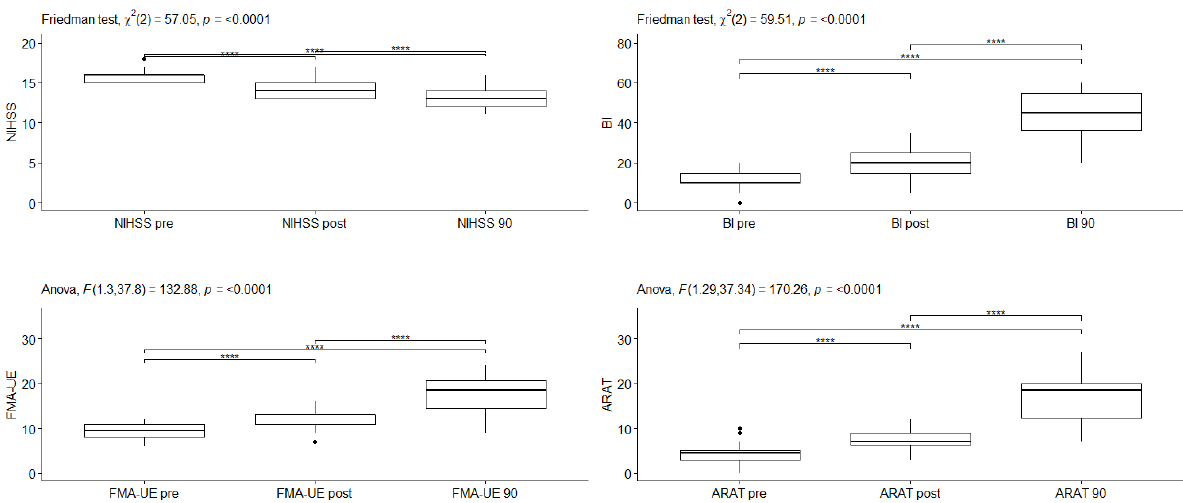
Figure 4. The changes in outcome measures over time for NIHSS, BI, FMA-UE, and ARAT in the Placebo group. The solid circles represent the outliers (without effect). **** p < 0.0001